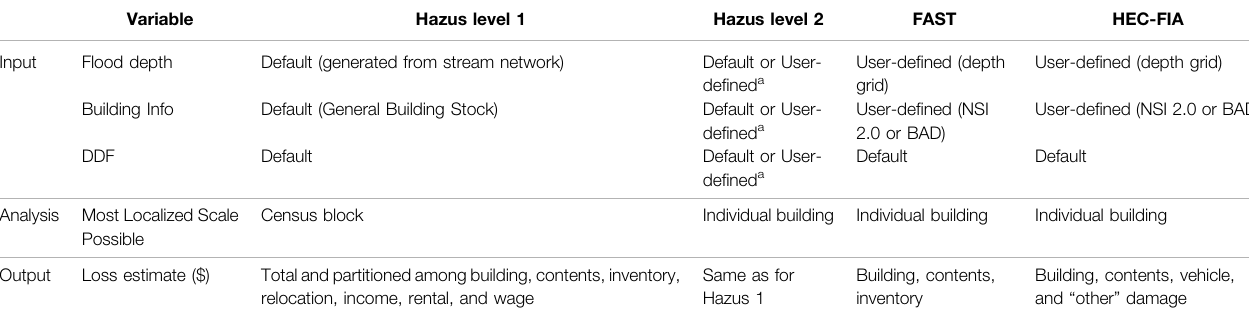
TABLE 1 | Years analyzed and data sources, for property losses, by hazard in